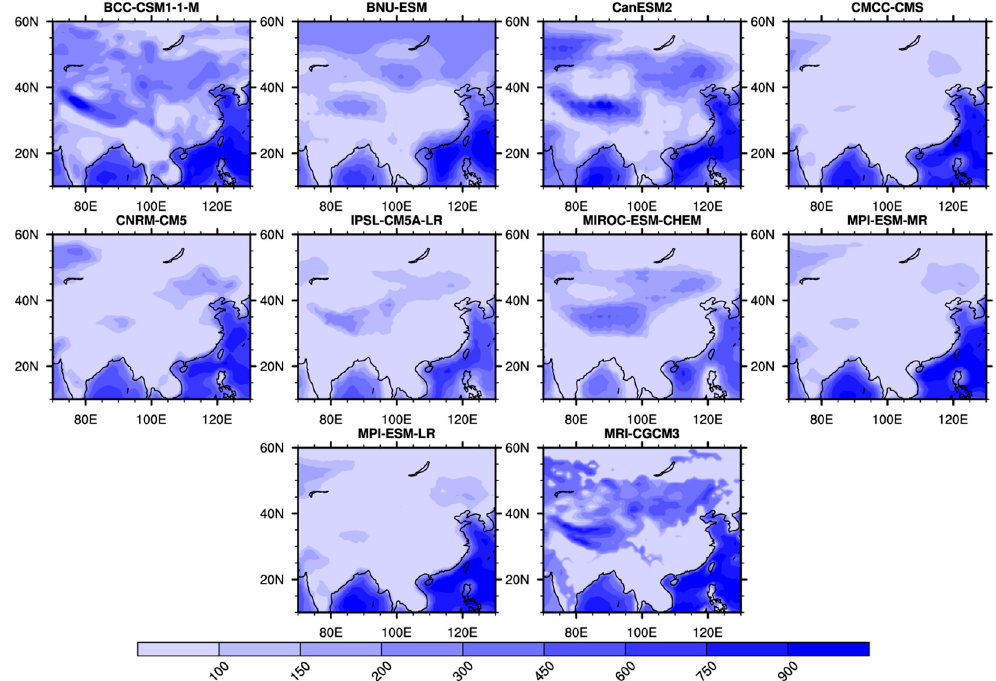
Figure A5. Spatial distribution of projected mean wind power density (WPD) in W / m 2 based on 90 m above ground level extrapolated wind speed for the 2061–2080 for the CMIP5 models under RCP8.5